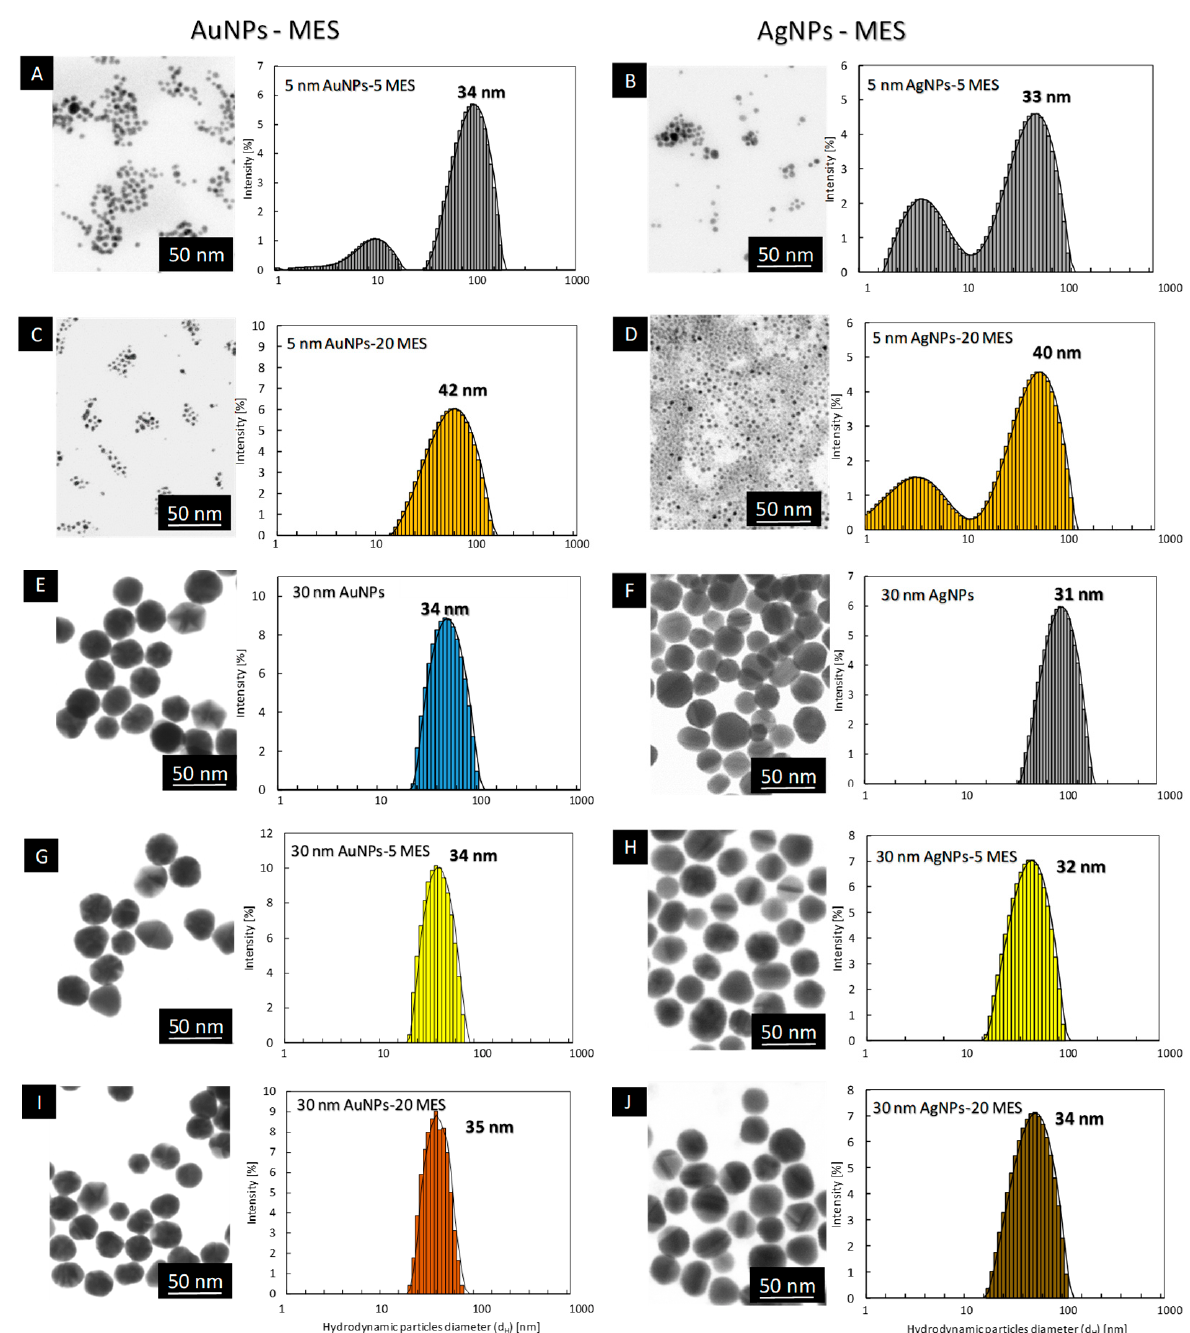
Figure 2. STEM images and DLS size distribution histograms of sulfonate-conjugated metallic nanoparticles: 5 nm AuNPs-5 MES ( A ); 5 nm AgNPs-5 MES ( B ); 5 nm AuNPs-20 MES ( C ); 5 nm AgNPs-20MES ( D ); 30 nm AuNPs ( E ); 30 nm AgNPs ( F ); 30 nm AuNPs-5 MES ( G ); 30 nm AgNPs-5 MES ( H ); 30 nm AuNPs-20 MES ( I ); 30 nm AgNPs-20MES ( J ).